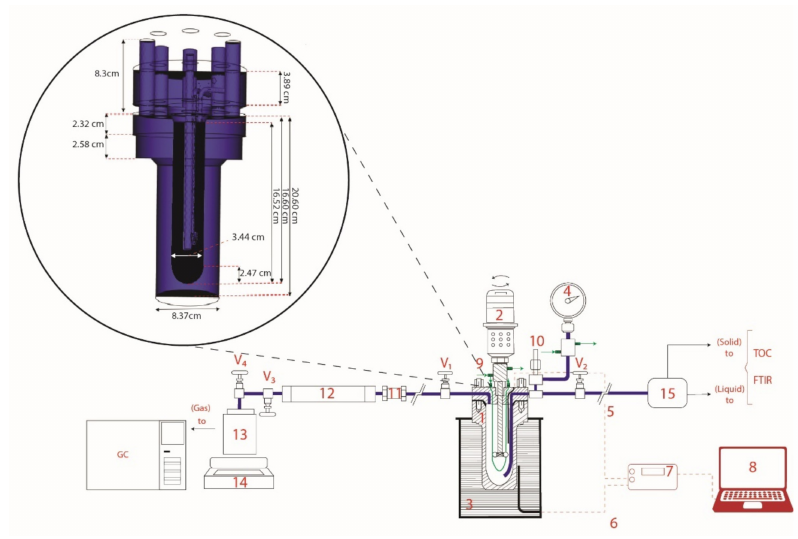
Figure 1. Schematic diagram of the